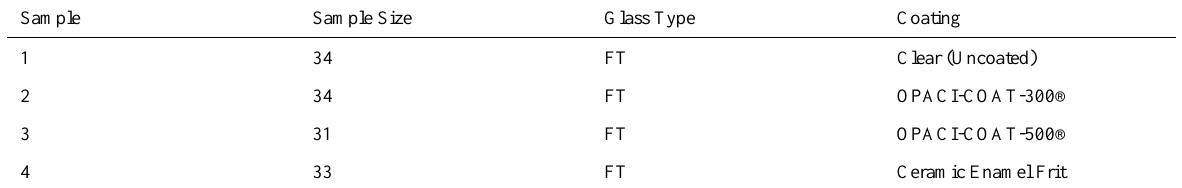
Table 2: Samples tested via ball